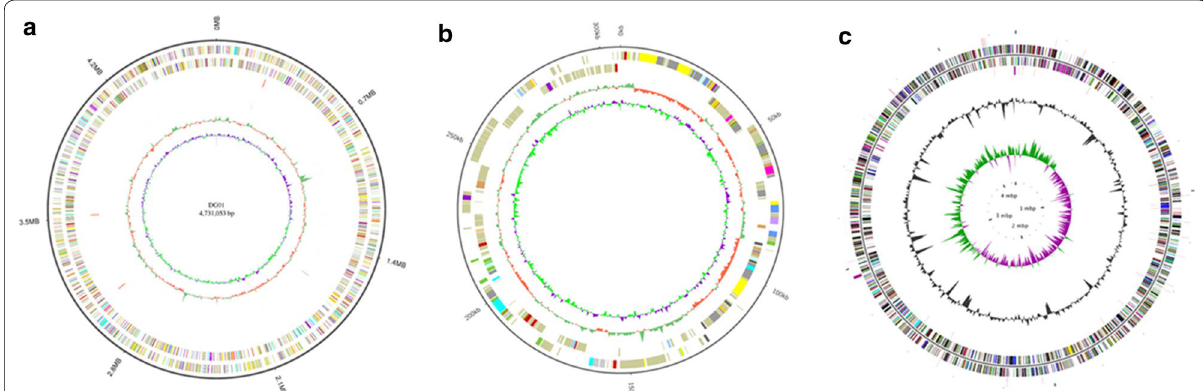
Fig. 6 Genome maps of H. latericoloratus CGMCC 16346 and P. indica CGMCC 6648. a Chromosome of CGMCC 16346. b Plasmid of CGMCC 16346. a , b (from outer to inner): genome size, forward strand gene colored according to COG classification, reverse strand gene colored according to COG classification, forward strand ncRNA, reverse strand ncRNA, repeat, G C content and GC skew. c Chromosome of CGMCC 6648 (from outer + to inner): forward strand ncRNA, forward strand gene colored according to COG classification, reverse strand gene colored according to COG classification, reverse strand ncRNA, G C content, and GC skew +